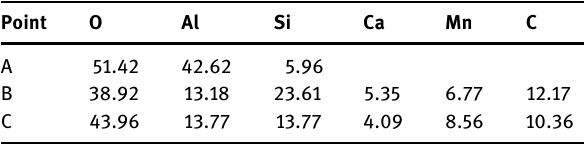
Table 7: Element mass fraction in selected point at crucible ( wt% ) Point O Al Si Ca Mn C A